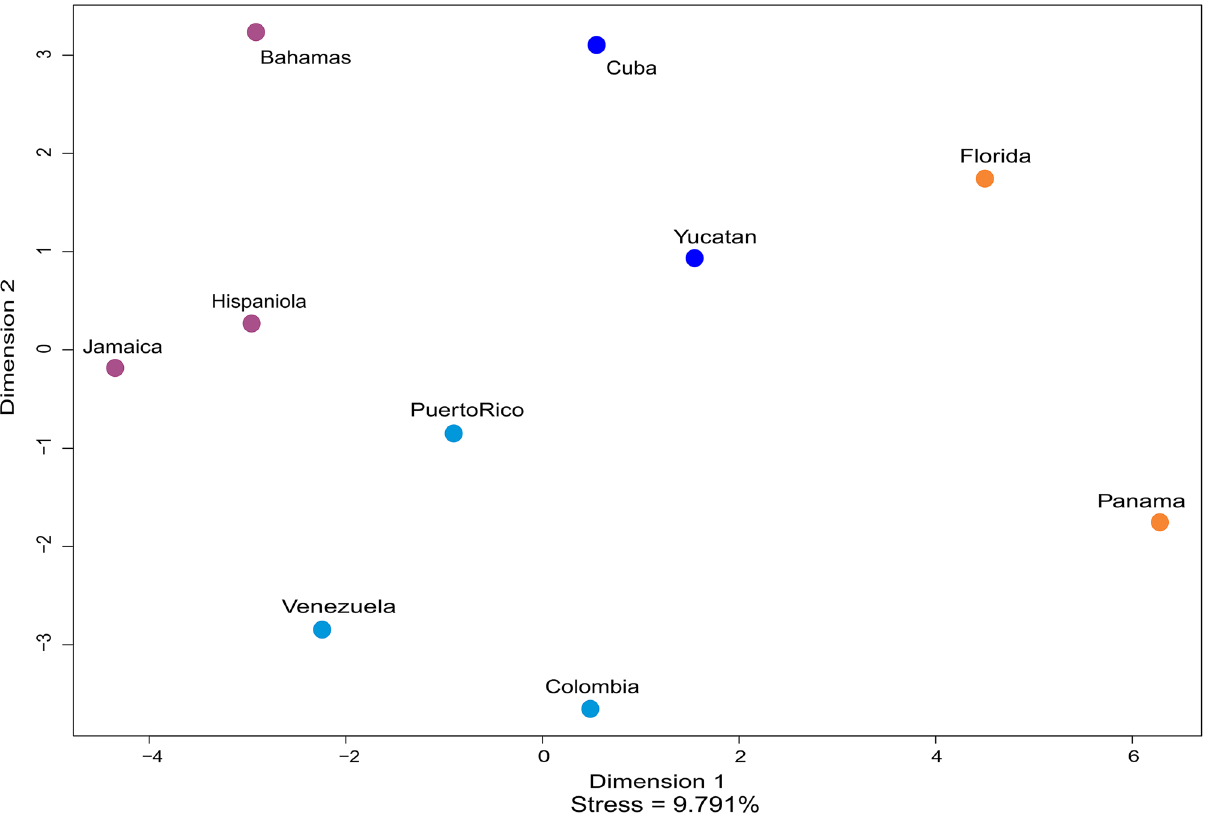
Figure 1. Morphological affinities among the series according to Multidimensional Scaling Analysis of the Mahalanobis Distances reported by Ross et al. 1 for 103 pre-Columbian individuals from 10 localities. Series colours follow the four clusters identified in Ross et al. 1 , Fig.